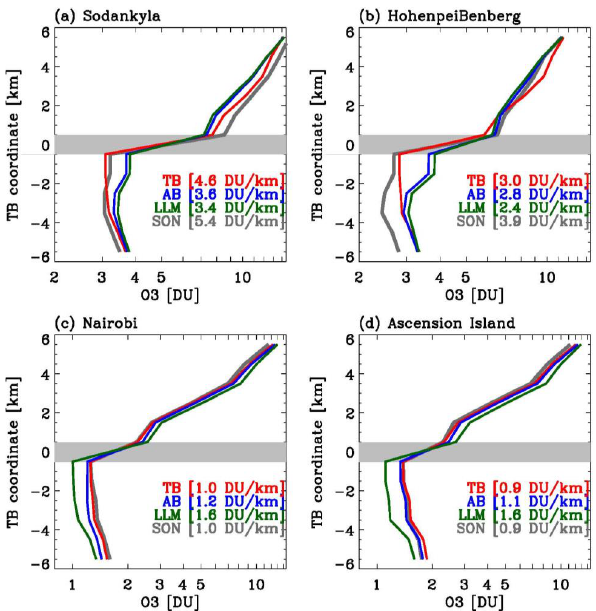
Figure 11. Averages of ozonesonde profiles (gray lines) as a function of altitude relative to the tropopause during the period 2004-2008 at four stations, and averages of collocated OMI profiles retrieved based on TB (red lines), AB (blue lines) and LLM (green lines) climatologies, respectively. The values given in DU/km represent the vertical gradients of ozone across the tropopause. Note that ozonesonde profiles are not convolved with OMI averaging kernels.